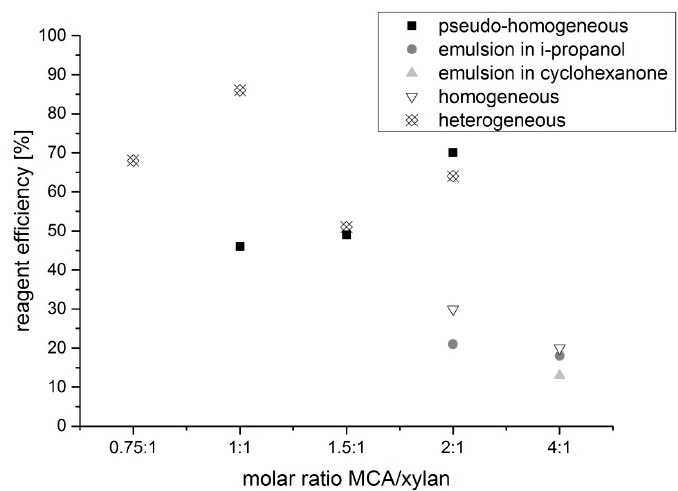
Figure 8. Reagent efficiency in dependence on the amount of used monochloroacetic acid (MCA) engaged for the various methods used.